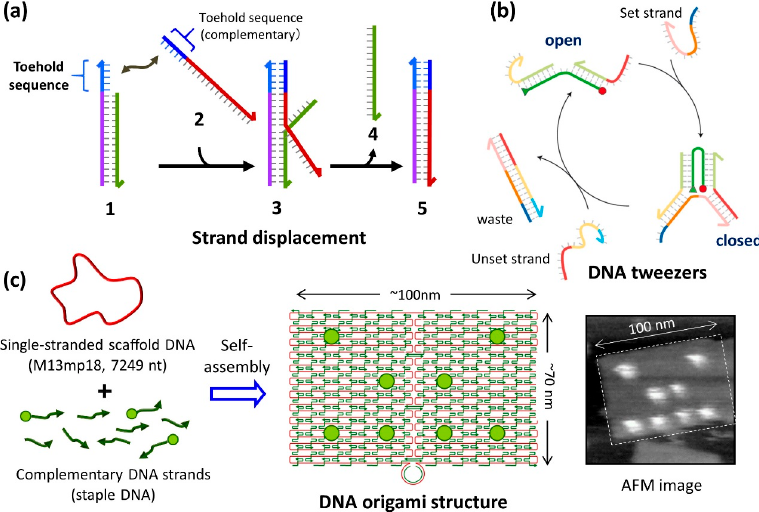
Figure 1. Operation of DNA machines and creation of nanostructures by DNA origami method. ( a ) DNA strand displacement reaction via toehold sequence used for operation of DNA nanomachine. ( b ) DNA tweezers using strand displacement reaction [5]. Set strand controls open to close state of the green DNA strand and unset strand removes the set strand to make open state. ( c ) The preparation of nanometer scale structure using DNA origami method. Long ssDNA (M13mp18) and short complementary DNA strands (staple DNA) are self-assembled by annealing [1]. When the target molecules (green circle) are bound to the staple DNA, the molecules can be placed at the predesigned positions on the DNA origami structure.